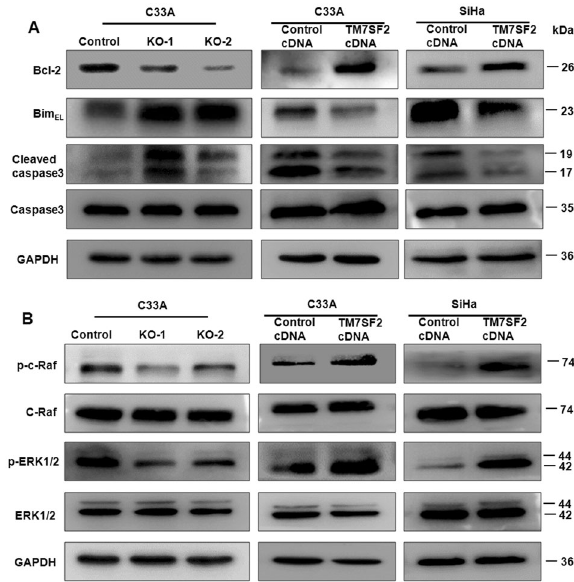
Fig. 5 TM7SF2 modulates the expression of apoptosis related proteins and C-Raf/ERK pathway. A Western blotting was utilized for measuring the expression of apoptosis related proteins in cells after TM7SF2 knockout or overexpression. B Western blotting was conducted to detect the effect of TM7SF2 knockout or over- expression on C-Raf/ERK signaling